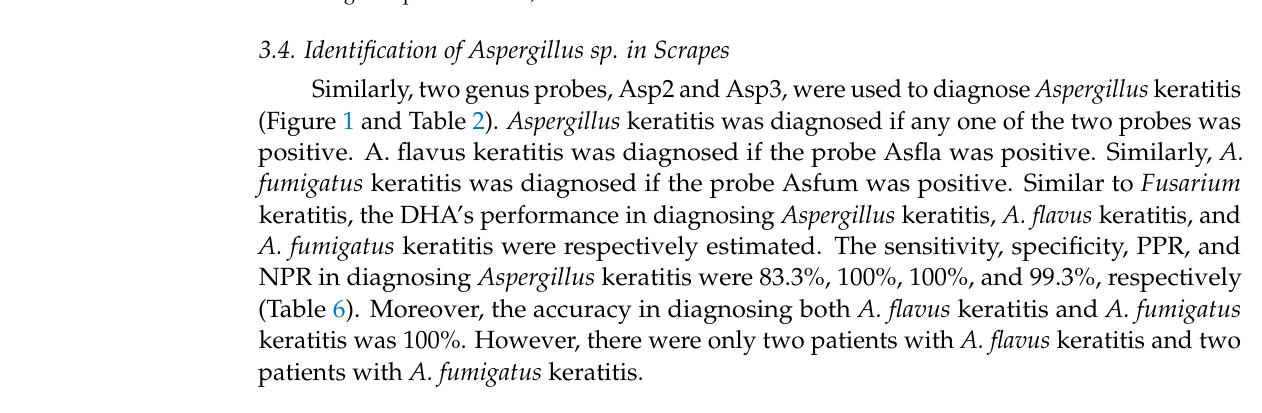
Table 6. Diagnostic performance of Aspergillus keratitis after discrepant